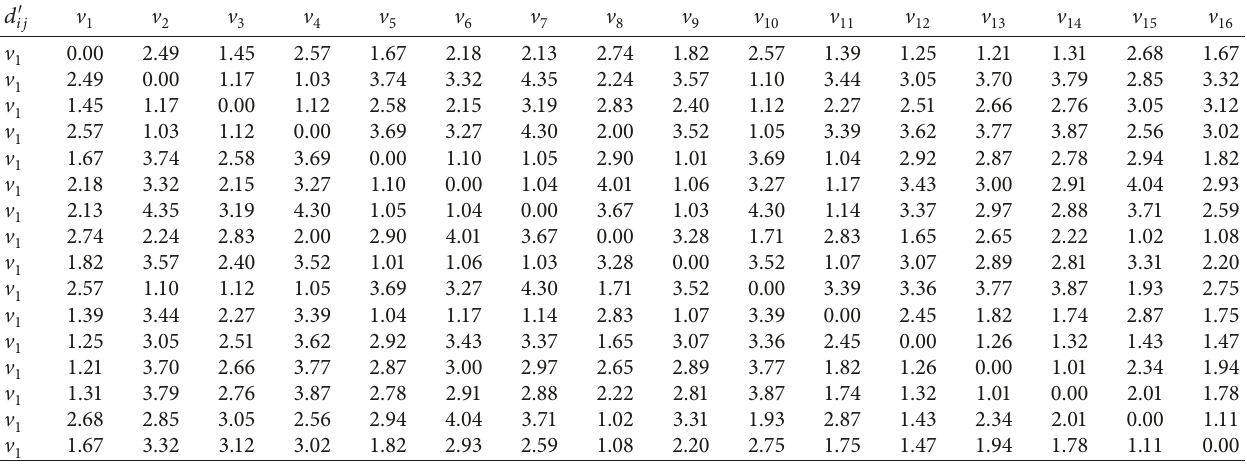
Table 3: The shortest distance between each pair of indexes.